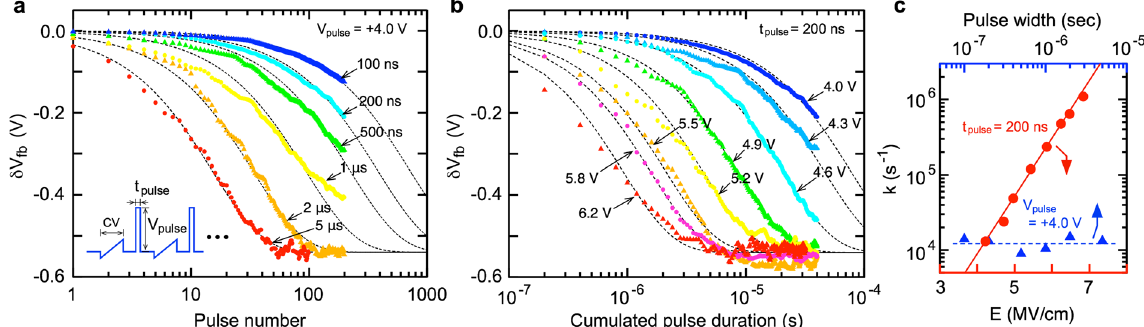
Figure 4. Pulse response characteristics of the four-stacked HfO 2 /SiO 2 IDM MOS capacitor. IDM MOS capacitor consists of 3.5-nm-thick top HfO 2 , 1.8-nm-thick inner SiO 2 , 1.8-nm-thick inner HfO 2 , and 5-nm- thick bottom SiO 2 layers. ( a ) V fb shift with various pulse widths and pulse voltage of + 4.0 V. The plotted δ V fb values show the voltage shifts from the initial V fb . ( b ) V fb shifts with various pulse voltages and a pulse width of 200 nsec. Dotted lines in Fig. 4a,b show the fitting curves based on the random bond breakage/repair model. ( c ) Reaction rate ( k ) as functions of electric field and pulse width.